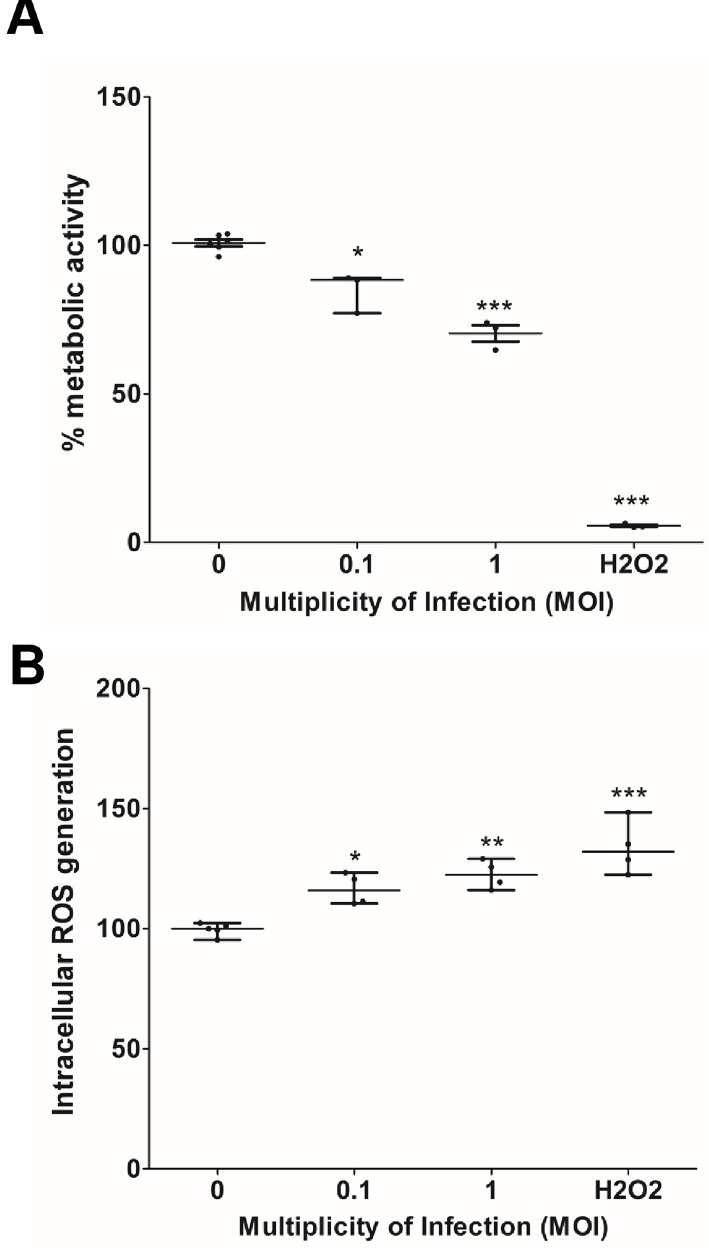
Fig 3. ZIKV infection of astrocytes modifies the metabolic activity and the production of species reactive oxygen. (A) Astrocytes-hNS1 were infected with ZIKV (MOI of 0.1 and 1), and at five dpi, viability was determined by indirectly measuring activity metabolism with resazurin. (B) The production of ROS was measured in mock-infected and ZIKV-infected cells at MOI of 0.1 and 1. In A and B, the data are median and interquartile range, n = 3–4, ** p < 0.01, *** p < 0.001, Kruskal Wallis with Dunn’s post hoc. For A and B, H 2 O 2 was used to induce cell death. protein that helps to maintain the shape of astrocytes, EAAT1 and EAAT2 are glutamate trans- porters that internalize glutamate in astrocytes and are thus the main regulators of excitatory glutamate neurotransmission. GS synthesizes glutamine using glutamate and ammonia as sub- strates, and with this protects neurons from the toxicity resulting from the excess of these